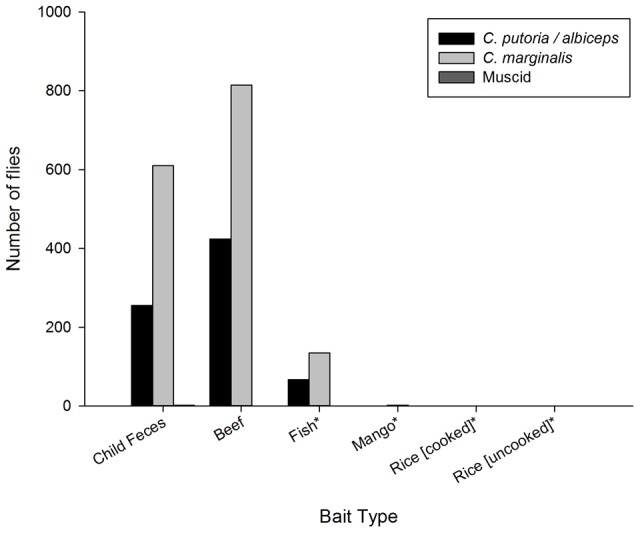
Relative attractiveness of different foods and child feces to flies.Where *Indicates a significant difference between the attractiveness of human feces and other media.